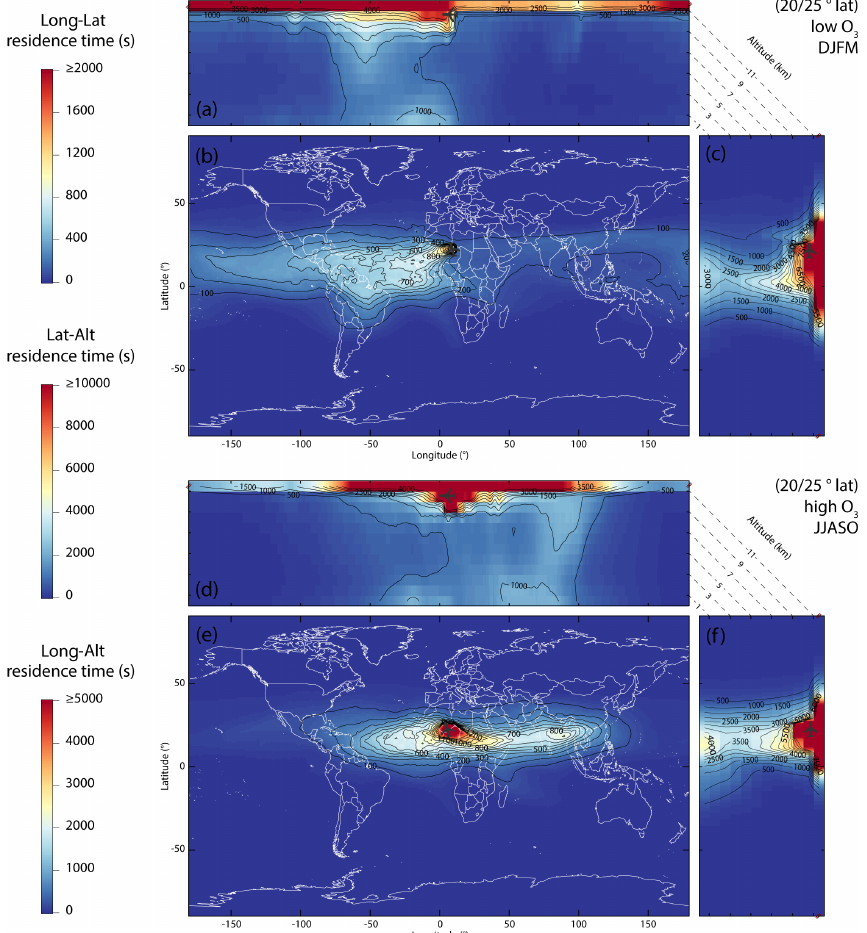
Figure 9. FLEXPART backward plume of air masses recorded by IAGOS flights between 20 and 25 ◦ N in DJFM (a, b, c) and JJASO (d, e, f) . Plumes are represented in terms of the residence time of particles in each individual output box in seconds, summed on the 20d backward, on 5 ◦ lat of flight and on total column (latitude column for a, d , altitude column for b, e , and longitude column for c, f ), and averaged over all studied years. Note that the color scale is different for longitude–altitude profiles (a, d) , longitude–latitude maps (b, e) and latitude–altitude profiles (c, f)